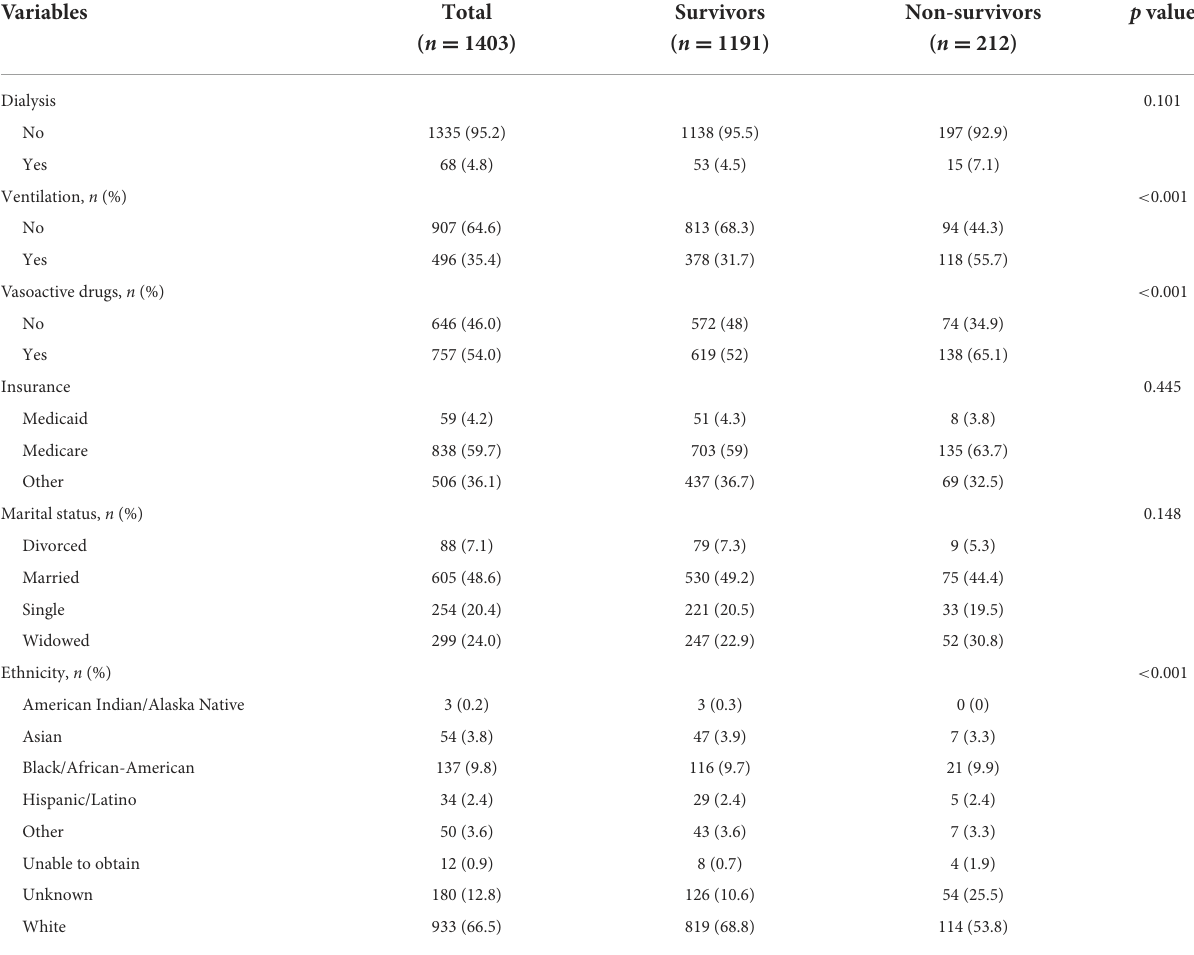
Supplementary material